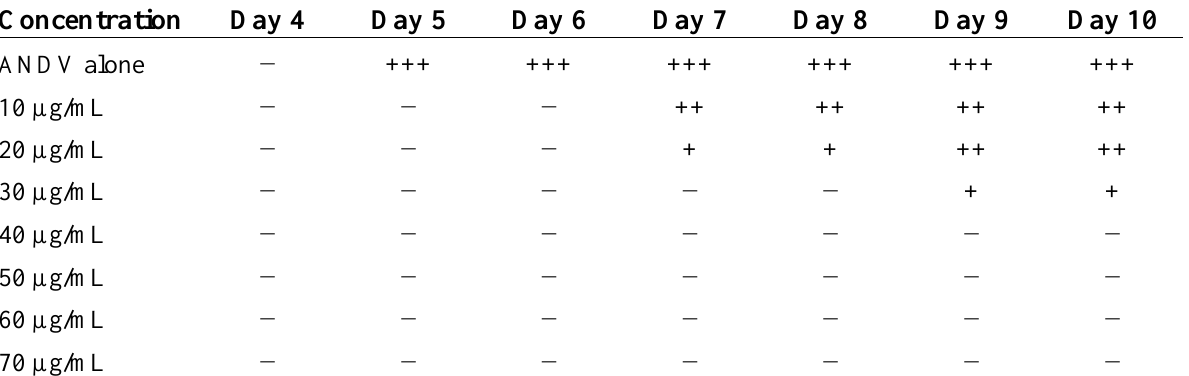
Table 1. Qualitative assessment of antiviral activity in a novel comet assay *.